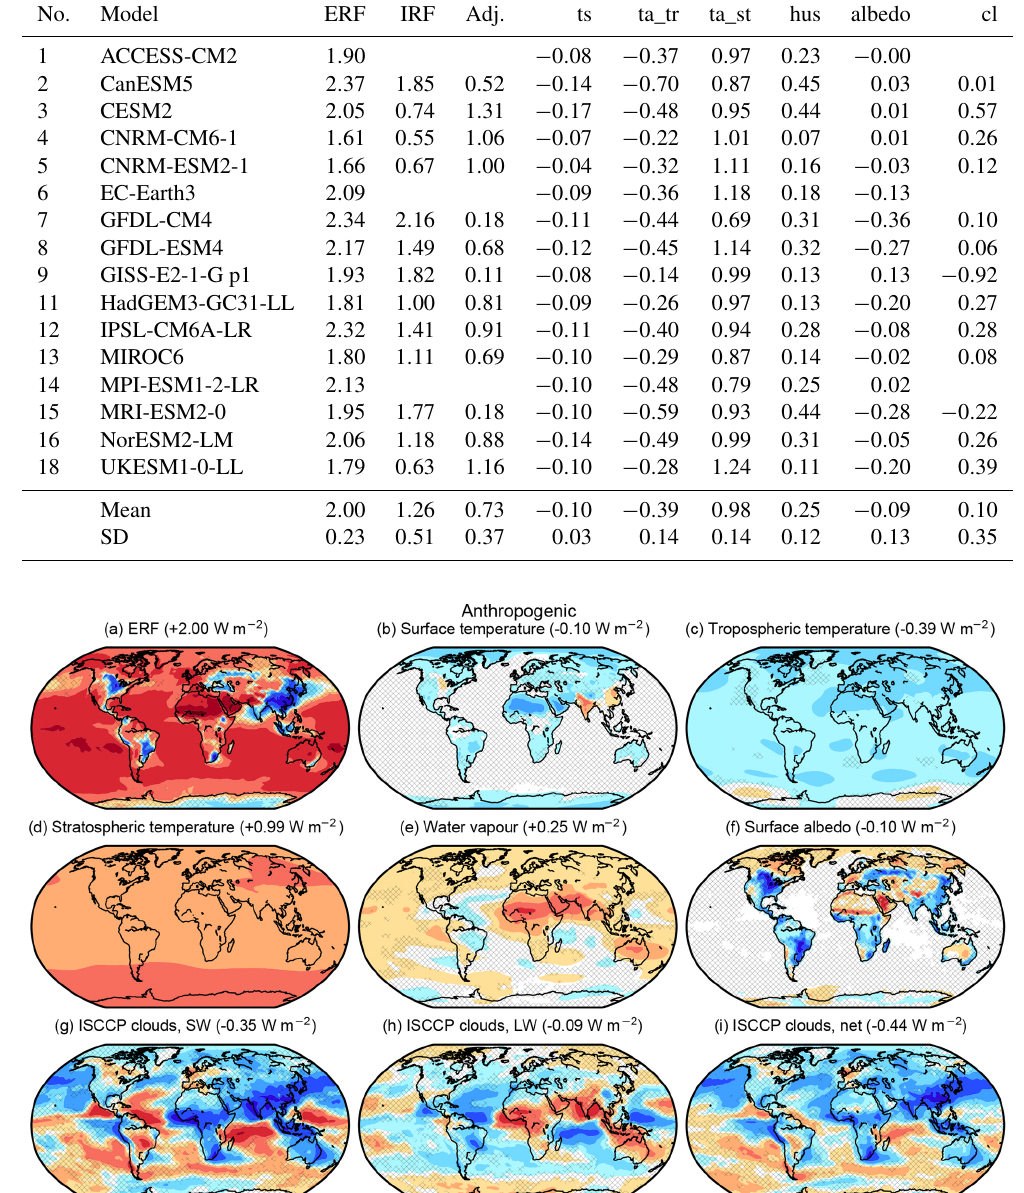
Table 8. As for Table 3 but for 1850–2014 anthropogenic forcing.